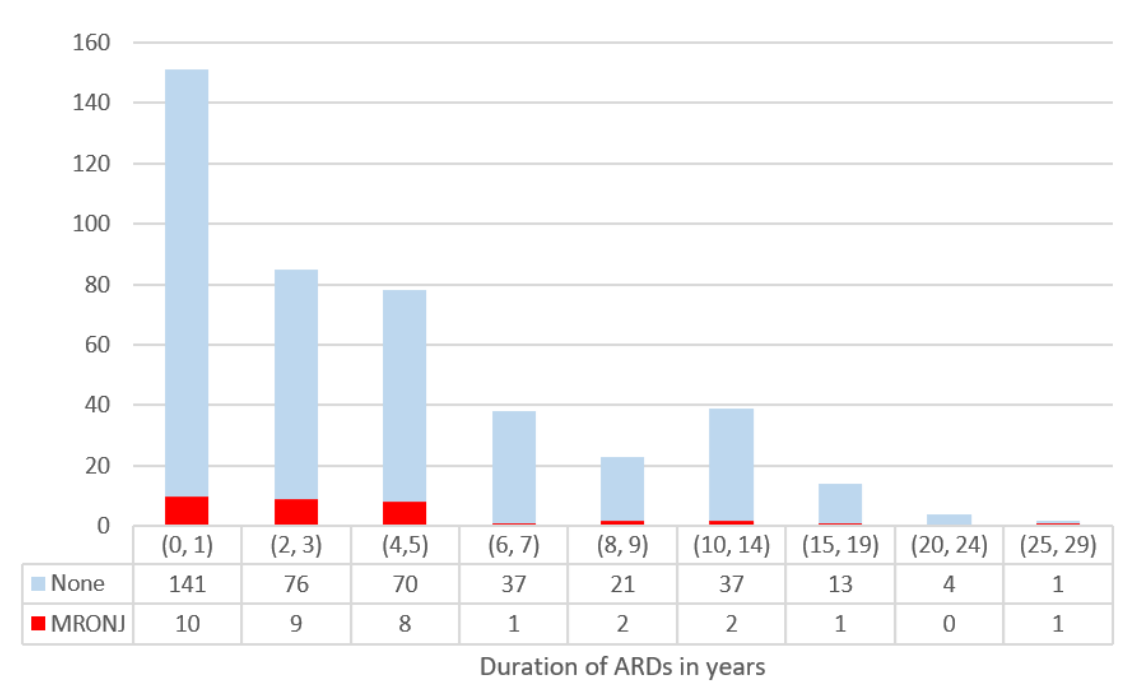
Figure 3. Detail of stratification by age.